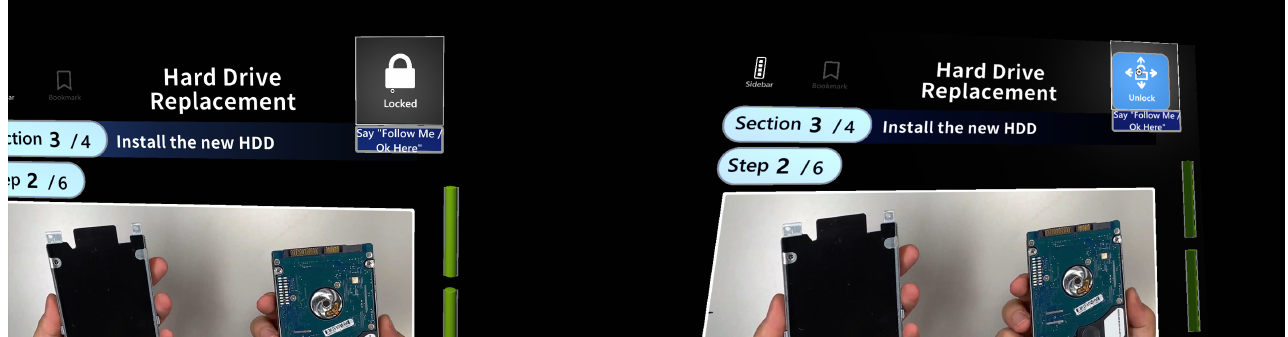
Figure 13. The color change that occurs when the user locks the position of virtual parts manage- ment box.